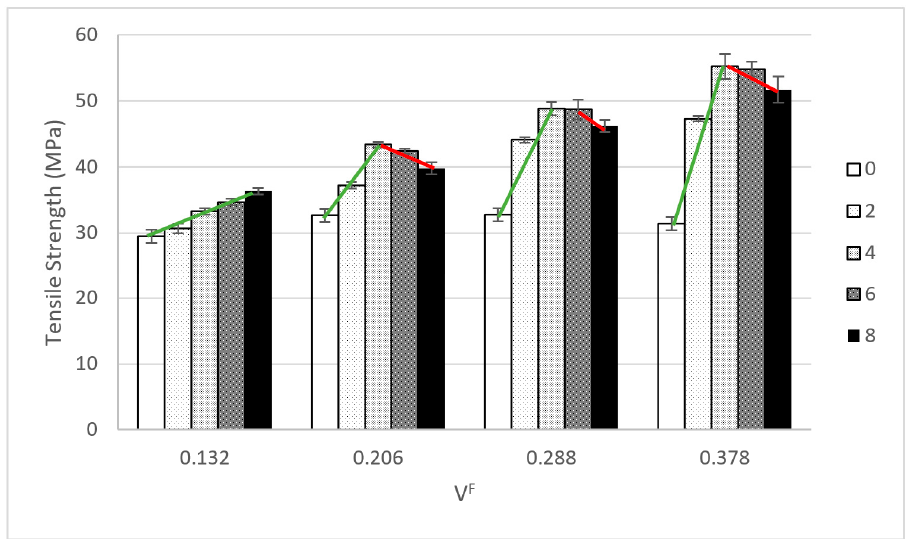
Figure 1. Evolution of the tensile strength of hemp strand reinforced polypropylene composites against coupling agent contents.